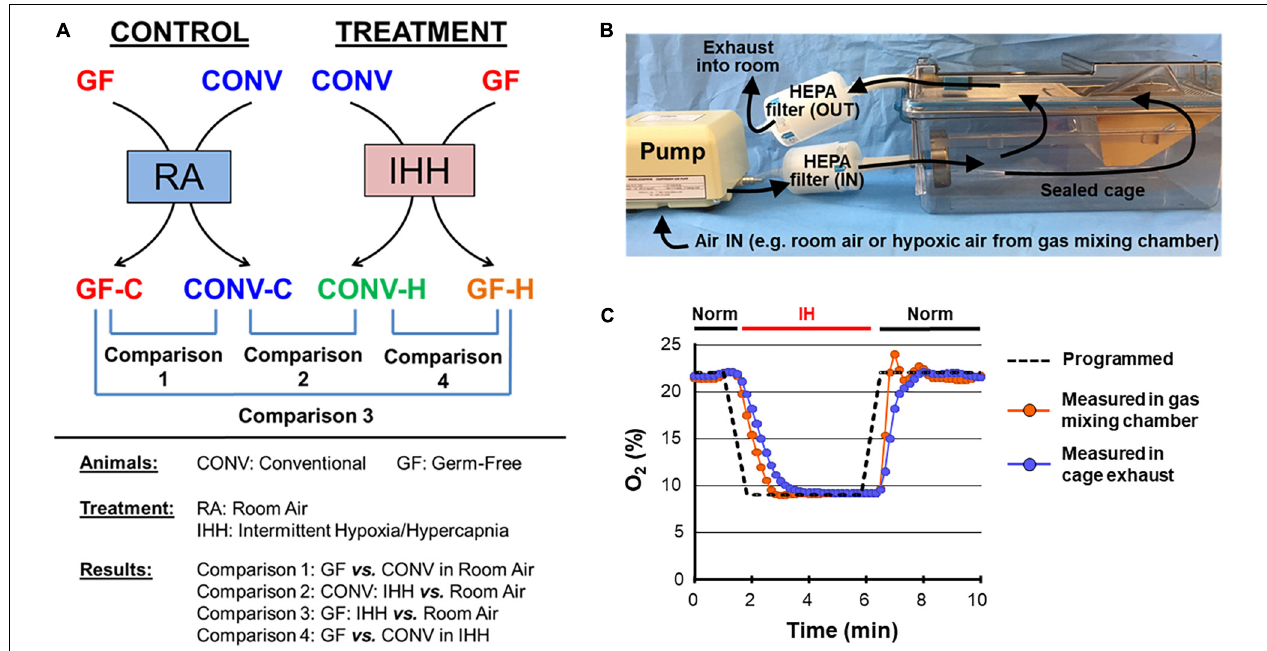
FIGURE 1 | Experiment design and instrumentation. (A) Conventional (CONV) and germ-free (GF) mice were treated with intermittent hypoxia/hypercapnia (IHH) or room air (RA) to determine the impacts of microbiome on heart transcriptome under normoxia and transcriptional response to IHH stress. (B) A tightly sealed cage system was developed to allow control of the cage atmosphere under gnotobiotic conditions by ventilating cages with a single, HEPA-filtered gas. The gnotobiotic chamber for treatment was supplied with IHH gas; room air was supplied to the control chamber. (C) A representative recording of a test run of the experimental setup with intermittent hypoxia (IH). The gas environment inside the cage was controlled by placing the pump inlet into a gas mixing chamber. IH was induced in the cage by obtaining gas from the gas mixing chamber with a programmed cycle of 5 min of 8% O 2 followed by 5 min of room air (21% O 2 ) (dashed black line). O 2 levels were measured directly in the mixing chamber (red symbols) or in the exhaust gas of the ventilated cage (blue symbols). IH, intermittent hypoxia; Norm, normoxia.